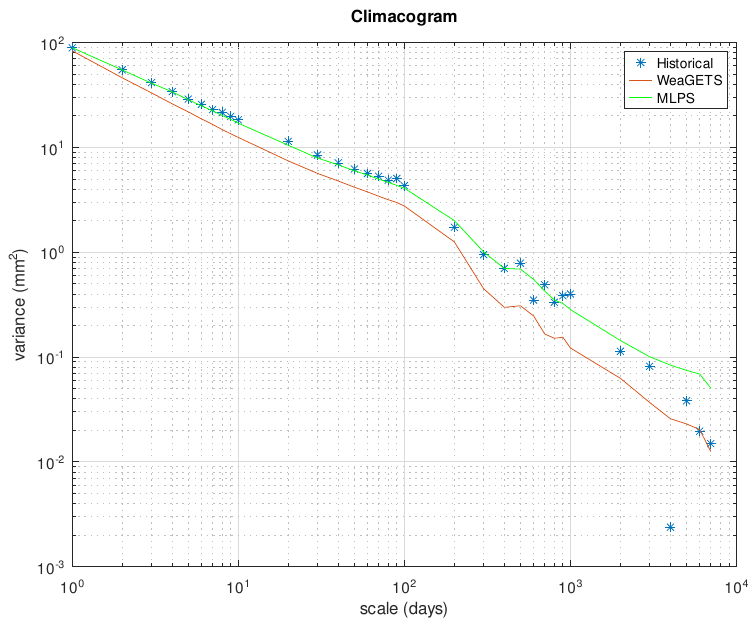
Figure 15. Climacogram of the Gibraltar time